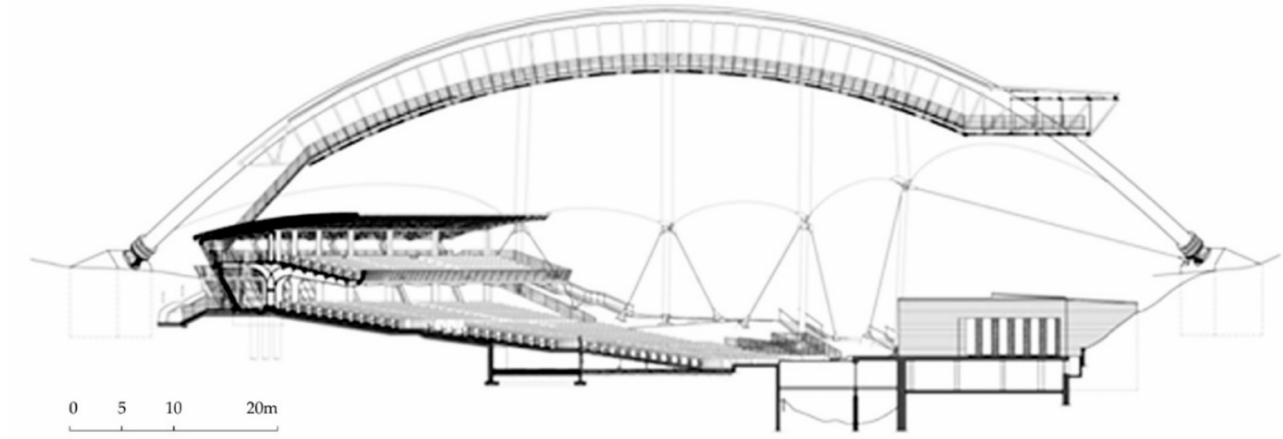
Figure 7. The scale of the main foundations of the load-bearing arch structure Forest Opera House in Sopot cross-section. https://inzynierbudownictwa.pl/stalowa-konstrukcja-z-motylim-dachem/10.05.2021 (accessed on 16 July